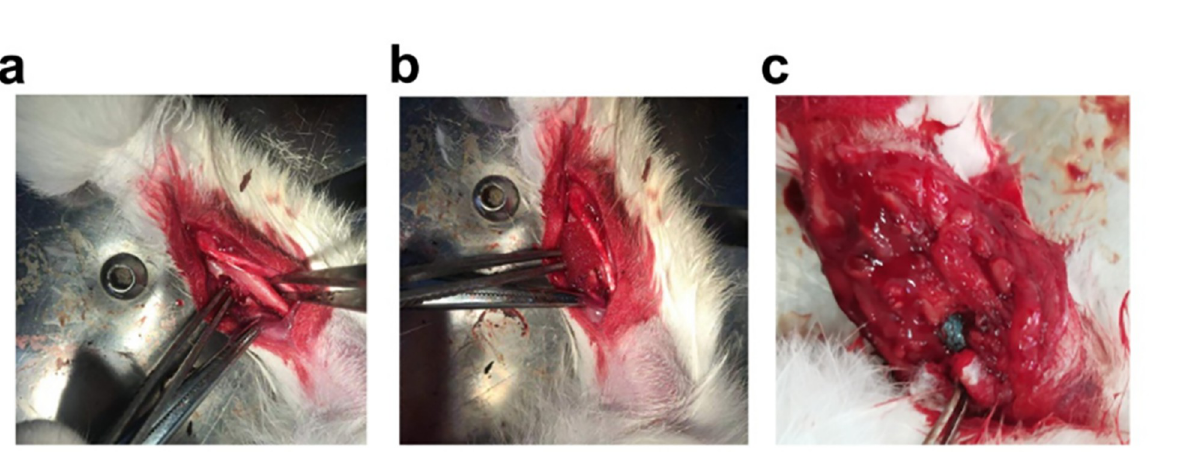
PLOS ONE | https://doi.org/10.1371/journal.pone.0277522 December8,